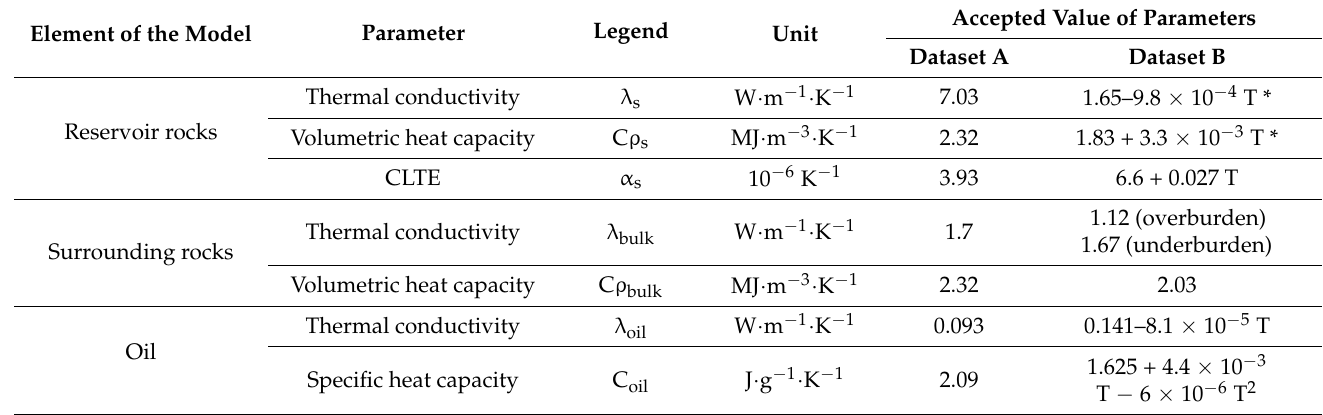
Table 4. Input datasets on rock thermal properties for